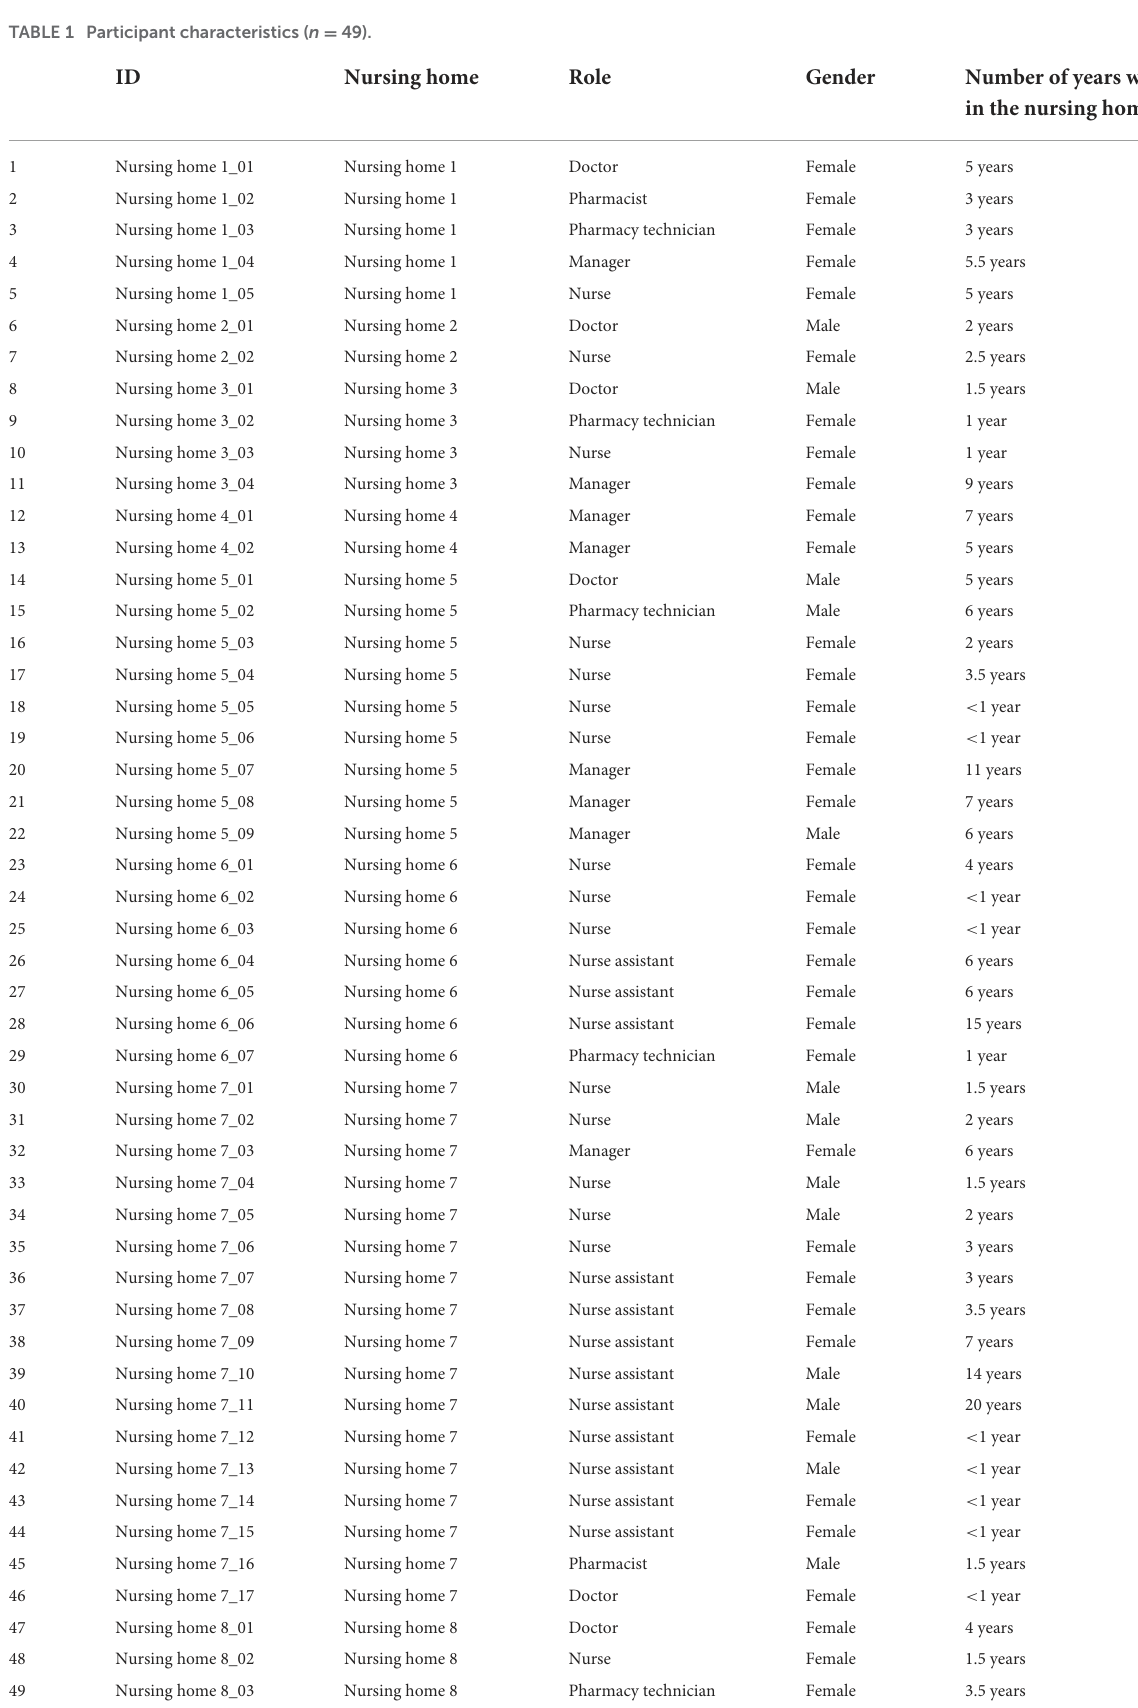
TABLE 1 Participant characteristics ( n =